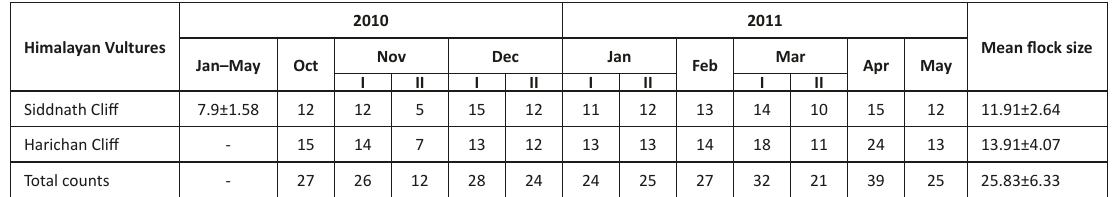
Table 1. Number of Himalayan Vulture observed on two different cliffs at Khodpe, Far-west Nepal. I and II denote the number of visit to the region. The mean flock size of Himalayan Vultures from January to May 2010 in Siddnath cliff only (no record in Harichan cliff) by Karmacharya (2011) is also shown in the table.